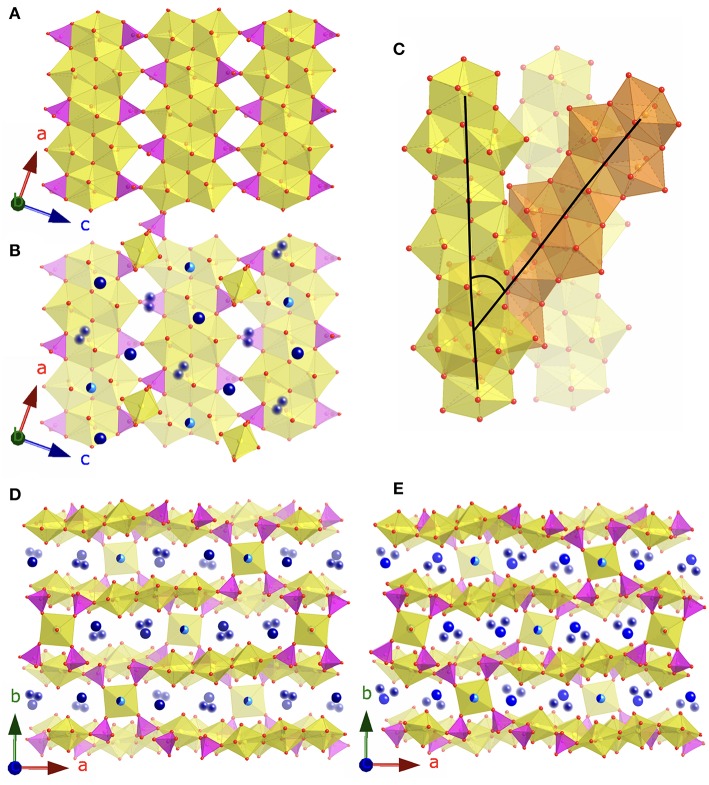
(A) The phosphuranylite layers found in 3 and 4. (B) The phosphuranylite layers plus the square bipyramid uranyl sites and alkali cations. (C) Depiction of the 37.8° torsion angle between chains in adjacent layers. (D) View of 3 in the c direction and (E) view of 4 in the c direction. Uranium, phosphate, and oxygen are shown in yellow, magenta, and red, respectively. Alkali cations are shown in blues, where blurred spheres represent partially occupied disordered sites, and the half light/dark blue spheres represent the Cs/K and Rb/K shared sites.